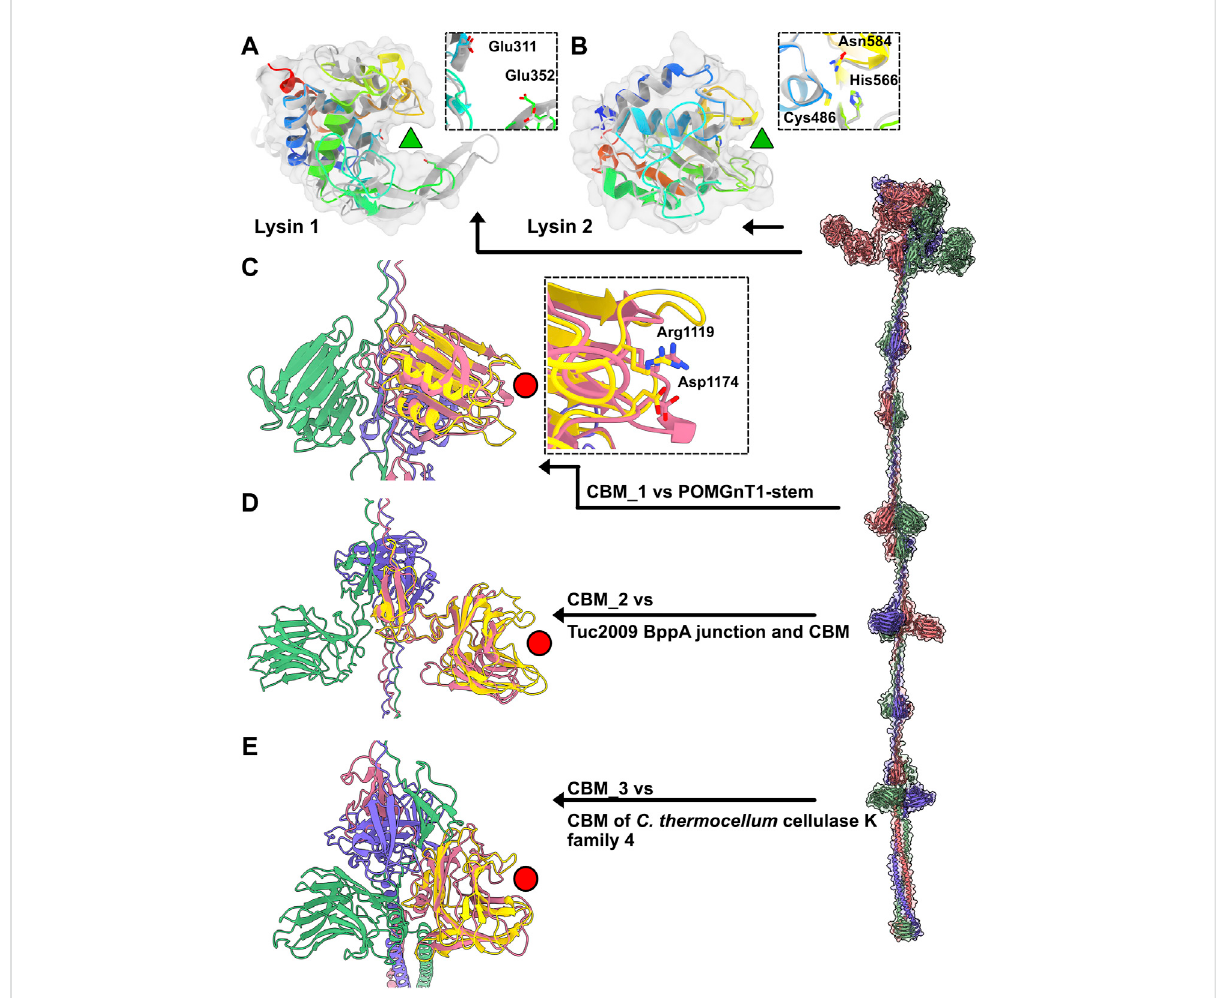
FIGURE 3 CatalyticandbindingdomainsofphageTP-778LTal. (A) RibbonandtransparentsurfacerepresentationofTP-778Llysin_1superimposedtothe catalyticdomainof L.monocytogenes autolysinAuto(Lmo1076)(PDBID3 fi 7;Table1),aN-acetylglycosaminidase(Bublitzetal.,2009).Thecatalytic residues of Auto occupied the same position as Glu311 and Glu352 of lysin_1 (residues shown as sticks). The active site cavity is indicated by a green triangle. Lysin_1 ribbon is rainbow colored, that of Auto is grey). (B) Ribbon and transparent surface representation of TP-778L lysin_2superimposedtoPlyCA,acysteine/histidine-dependentamidohydrolases/peptidase(CHAP)domain(McGowanetal.,2012).Atriadinlysin_2 (Cys486, His566, Asn584) occupies the same position as that of PlyCA catalytic triad (Cys333, His420, Asn438) within the catalytic crevice indicated byagreentriangle.Lysin_2ribbonisrainbowcolored,thatofPlyCAisgrey). (C) RibbonrepresentationofTP-778LTalCBM_1(pink)superimposedto the stem domain (yellow) of the Protein O-Linked Mannose N-Acetylglucosaminyl-transferase 1 (Kuwabara et al., 2016) (POMGnT1-Stem, PDB ID 5ggf). The two residues of POMGnT1-Stem Arg129 and Asp179, shown as sticks, are involved in host CWPS binding. The position of these two residues are conserved in CBM_1 (Arg1119 and Asp1174) and are located at the extremity opposite to the trimerization axis (red circle). (D) Ribbon representationofTP-778LTalCBM_2(pink)superimposedtothejunctiondomainandCBMofphageTuc2009 BppAbaseplateprotein(yellow,PDB ID 5e7t). The binding site cavity is indicated by a red circle. (E) Ribbon representation of TP-778L Tal CBM_3 (pink) superimposed to the CBM of C.lostridium thermocellum cellulase K family 4 (yellow, PDB ID 3p6b). The binding site cavity is indicated by a red